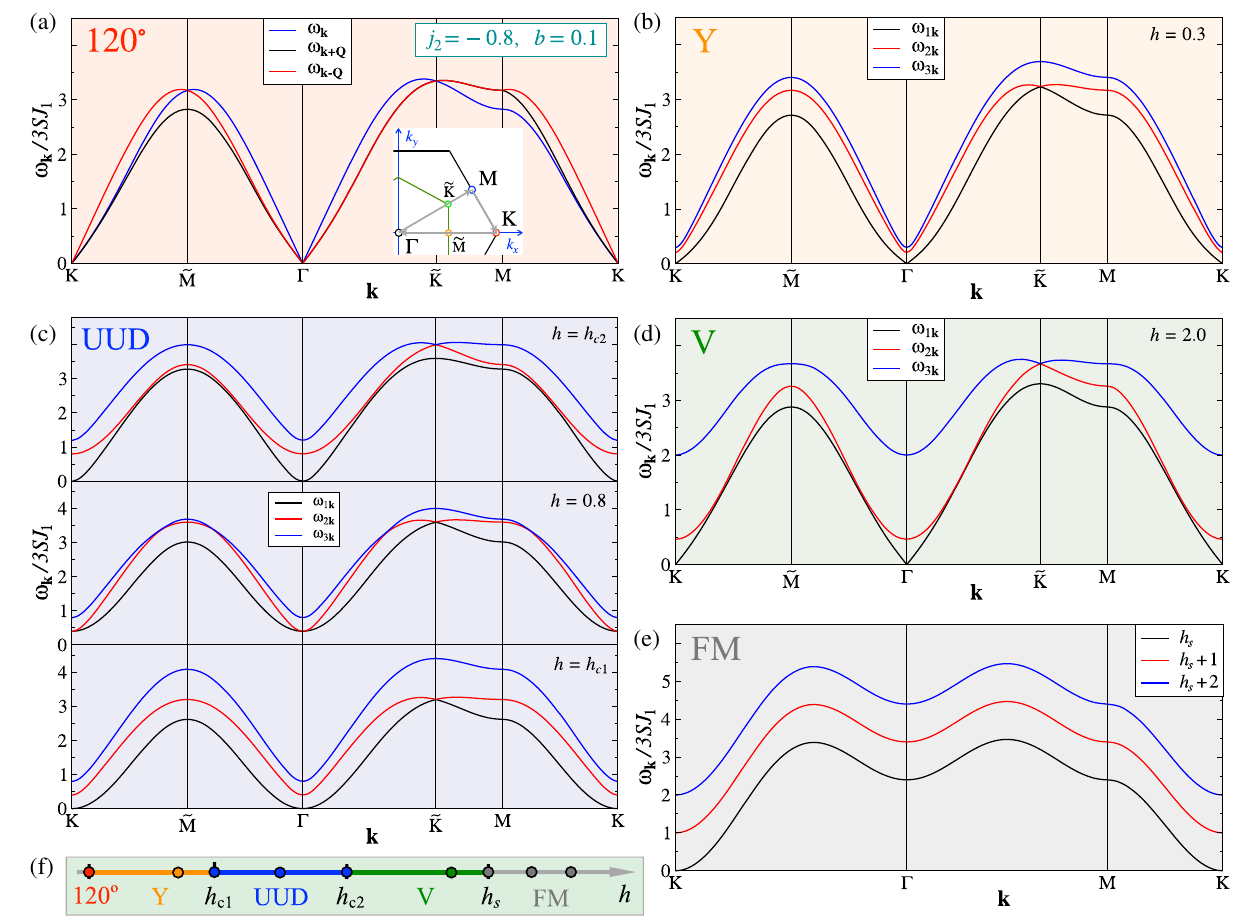
FIG. 6. Magnon energies in units of 3 SJ 1 for several representative field values from the phases sketched in Fig. 4, j 2 ¼ J 2 =J 1 ¼ − 0 . 8 and b ¼ BS 2 =J 1 ¼ 0 . 1 . (a) 120°-phase, h ¼ 0 ; (b) Y phase, h ¼ 0 . 3 ; (c) UUD phase, h ¼ h (d) V phase, h ¼ 2 . 0 ; (e) FM phase h ¼ h 3 ð 1 − 2 b Þ . The 1D phase diagram vs field with representative field values is sketched in panel h s ¼